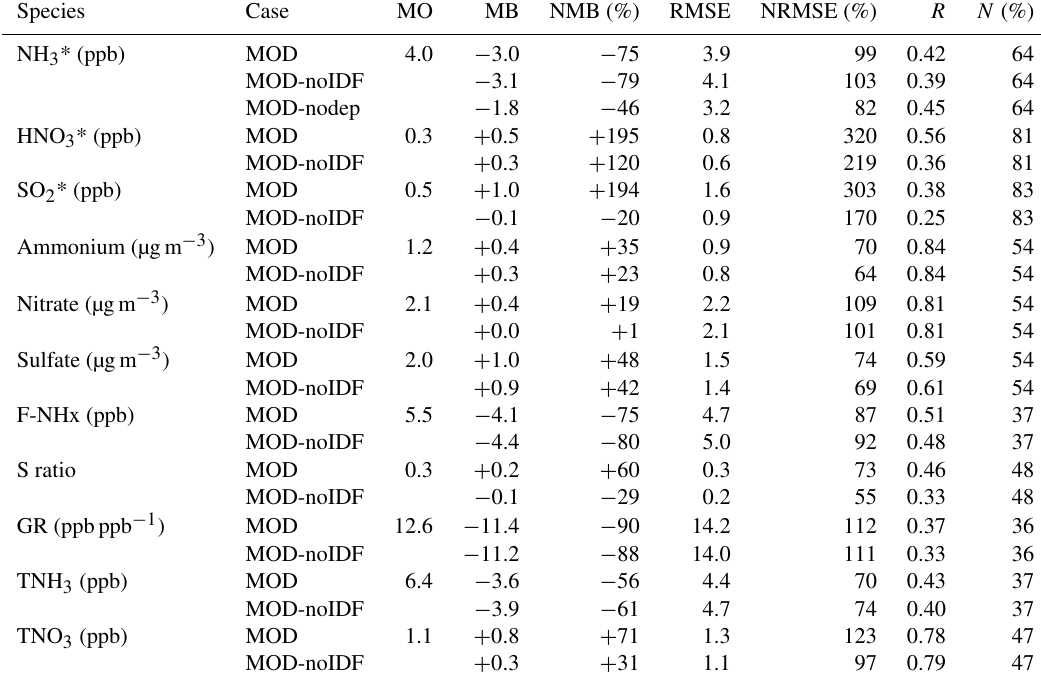
Table 1. Statistical results at our urban background sites over the whole period (all statistical metrics are defined at the beginning of Sect. 4; MO is the observed concentration mean, N the data